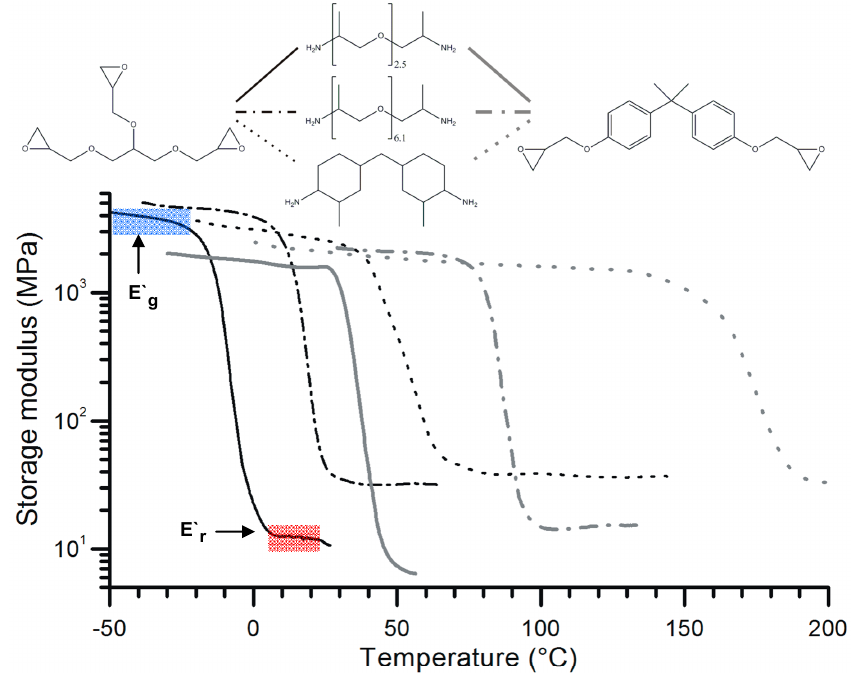
Figure 2. Effects of selected formulations (types of EP resins and hardeners) on the viscoelastic response of amine-cured EPs.